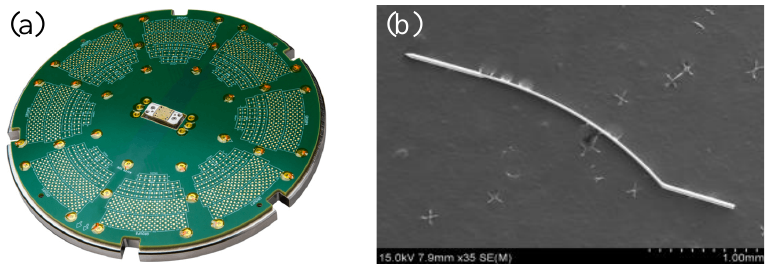
Figure 2. Photos of ( a ) probe card and ( b ) card pin.